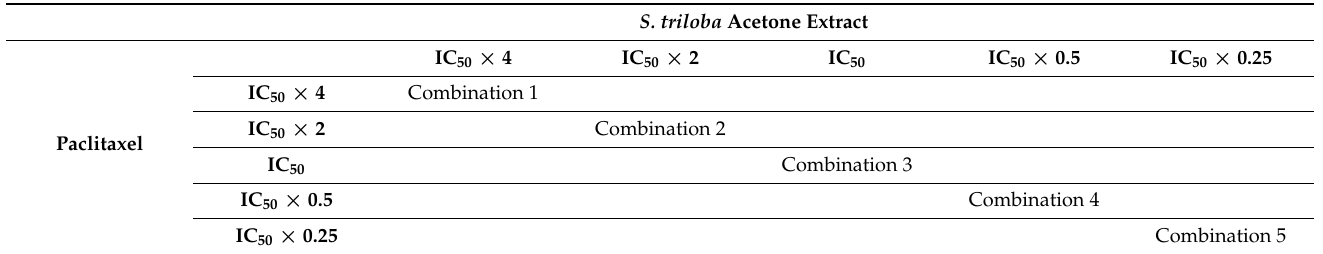
Table 1. Serial dilution scheme for the combination